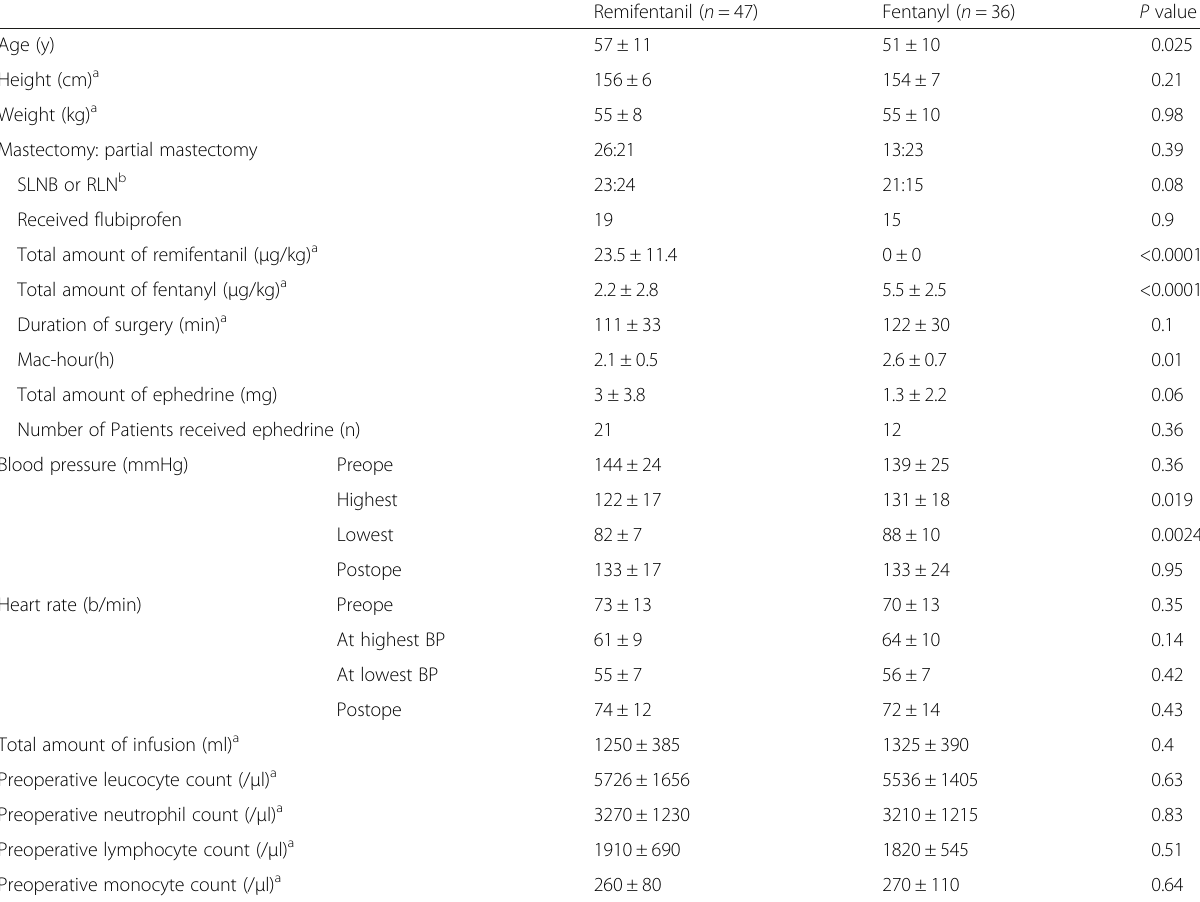
Table 1 Characteristics of the patients who received remifentanil-based anesthesia or fentanyl-based